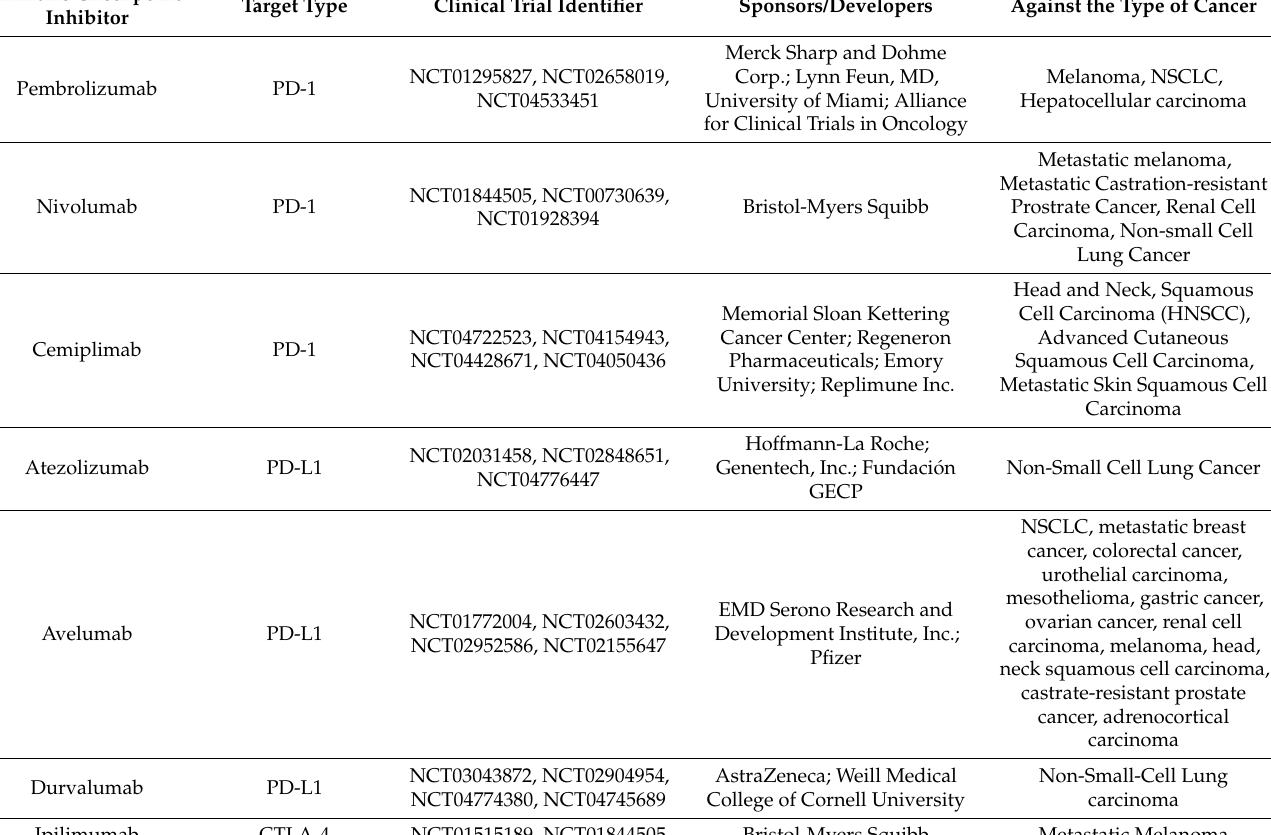
Table 1. Immune checkpoint inhibitors ongoing and completed clinical